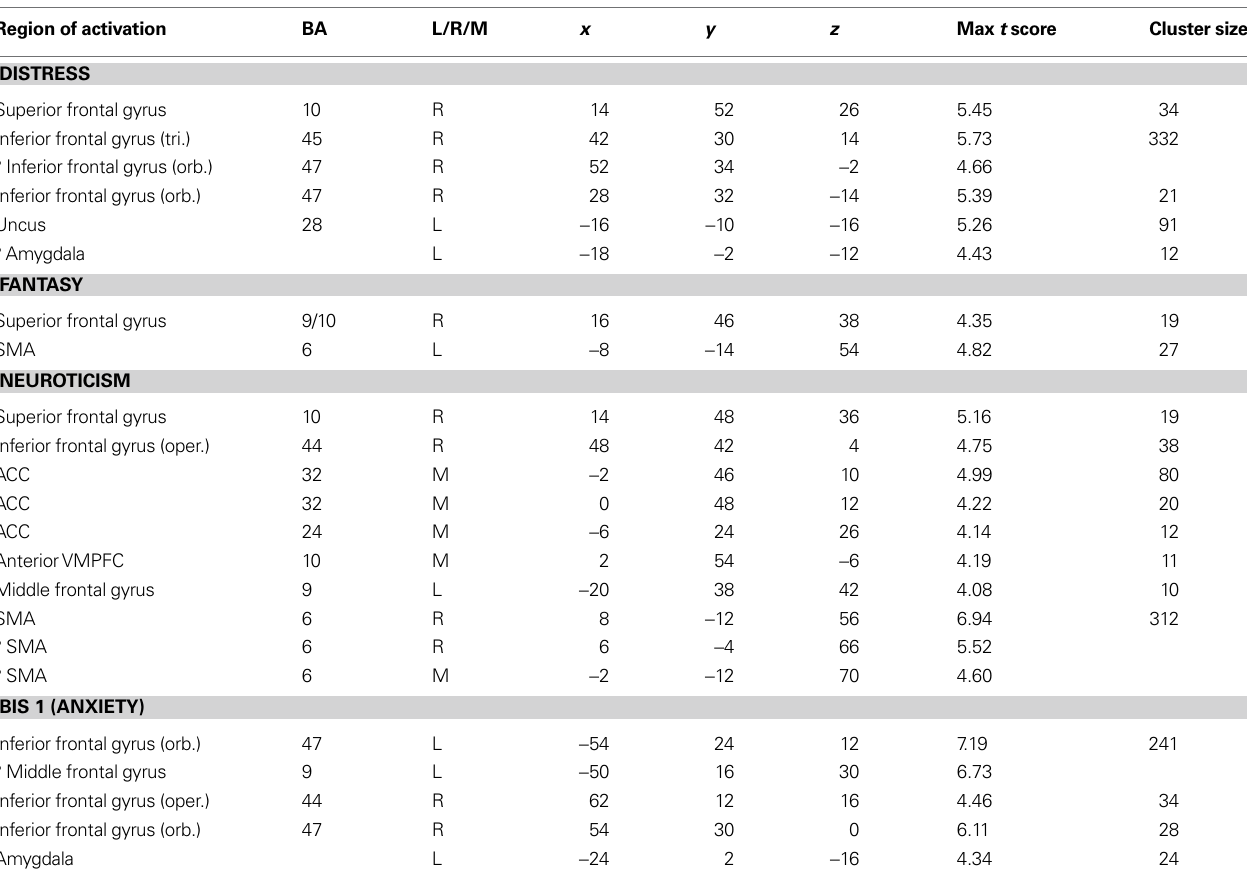
Table 2 | Sites of activation related to Distress, Fantasy, Neuroticism and Anxiety in a priori defi ned regions of interest. Coordinates in MNI space and maximum t values are shown for local voxel maxima in each cluster (SPM{t} maps thresholded at p < 0.001 uncorrected for multiple comparisons, with a cluster extent threshold of 10 voxels).